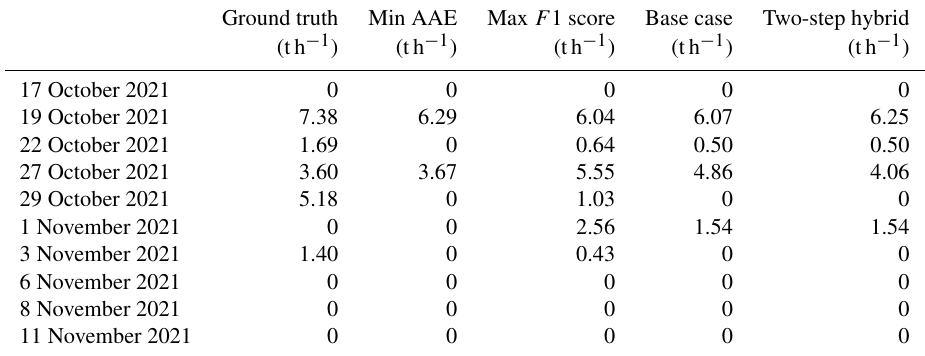
Table 2. Emission rate estimates of scenario